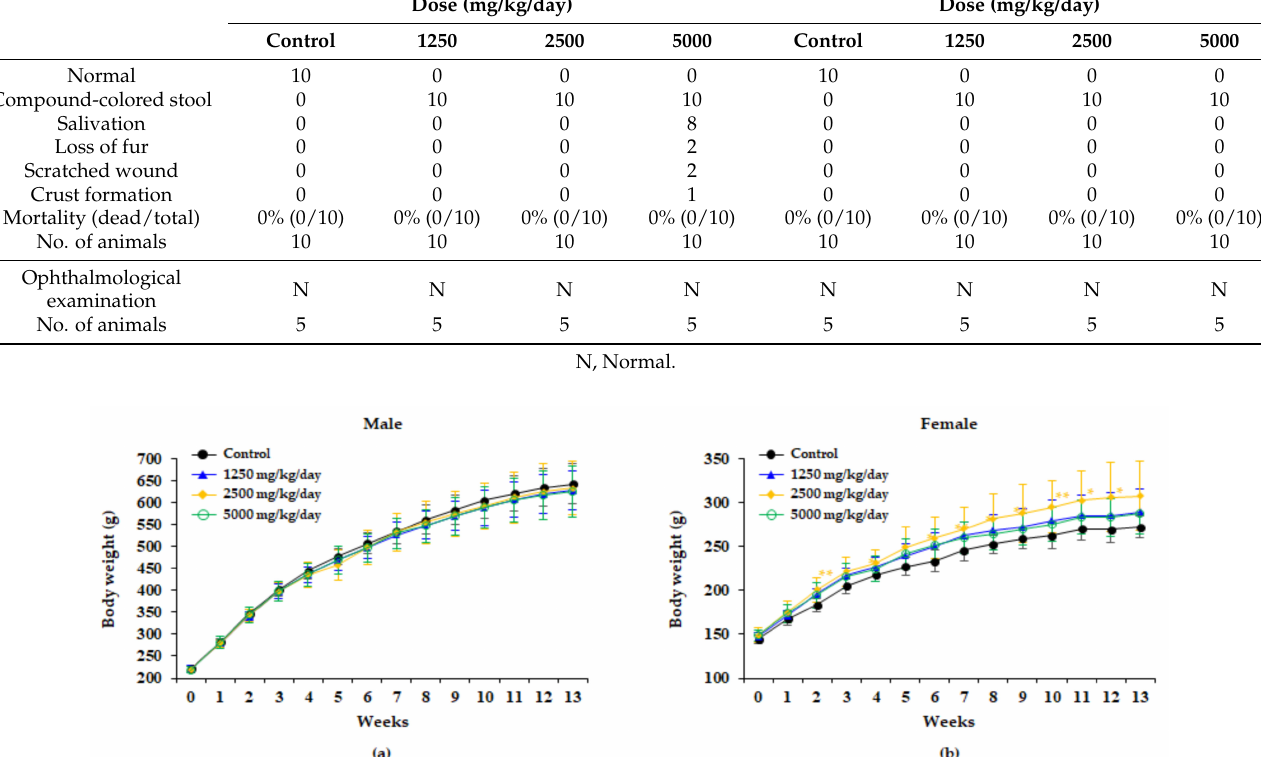
Observation Type